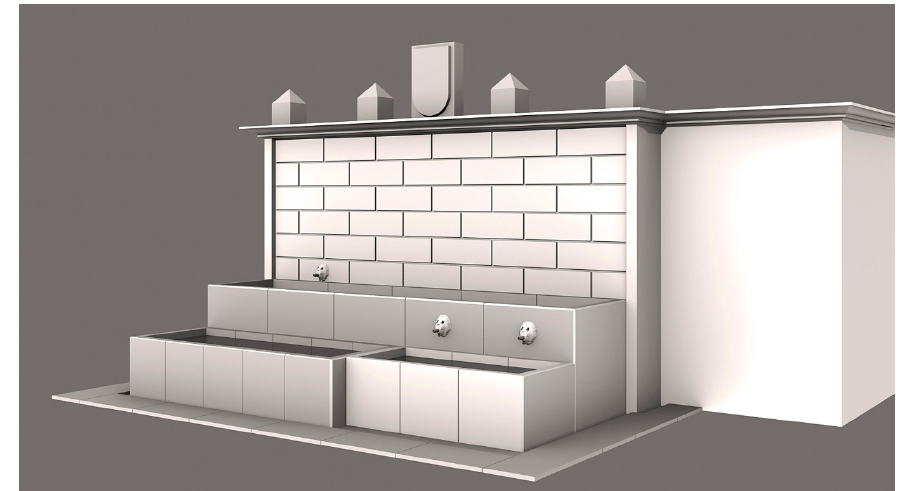
Figure 12. Perspective of the graphic reconstruction of the fountain of La Magdalena in Lugo. The image was provided by the authors.